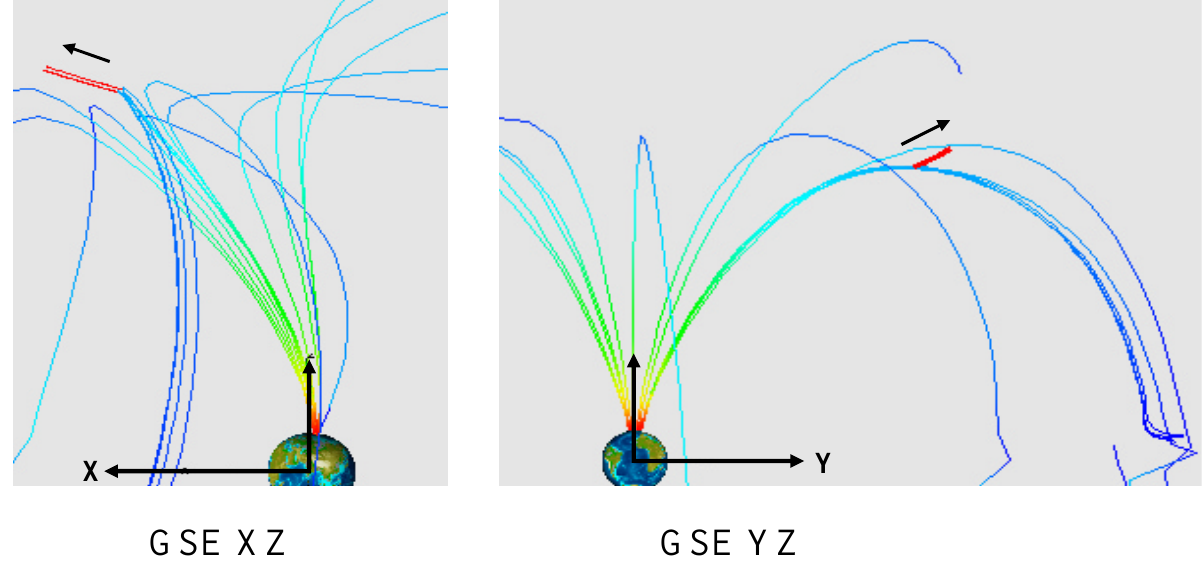
Fig. 1. An illustration of the flight path (in red) of Cluster from 12:30 to 14:00UT in a GSE X − Z and Y − Z plane. Cluster moved radially outward in the dusk sector for the actual time